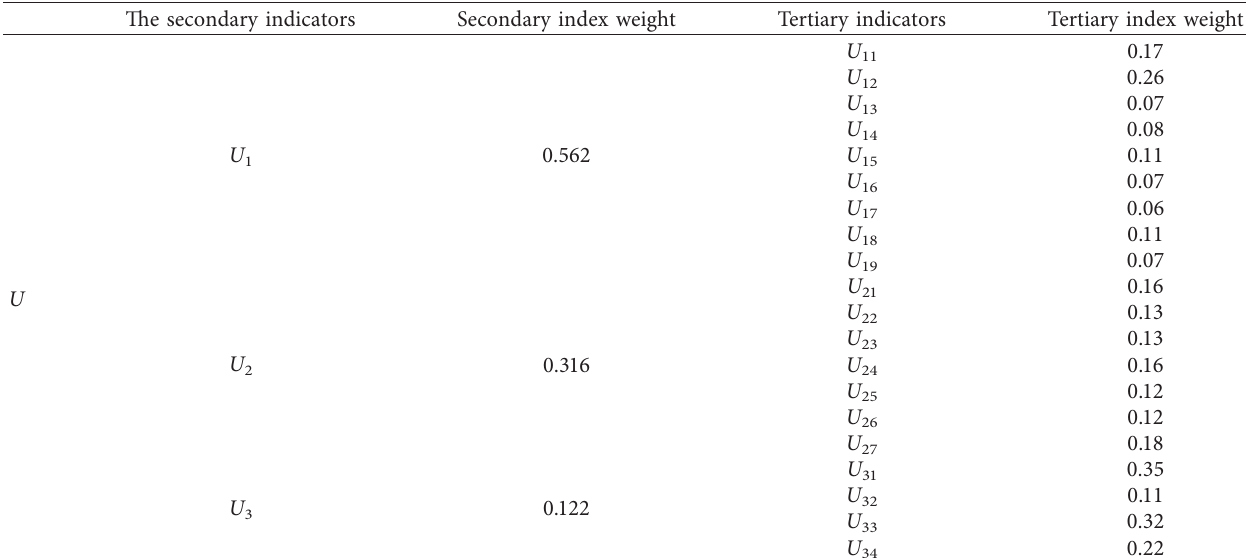
Table 6: Risk index weights of entropy weight